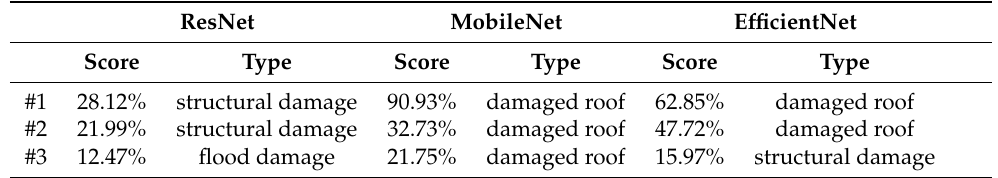
Table 4. Summary of confidence scores and associated object categories for the top three predictions made on the image of a damaged roof for each of the three